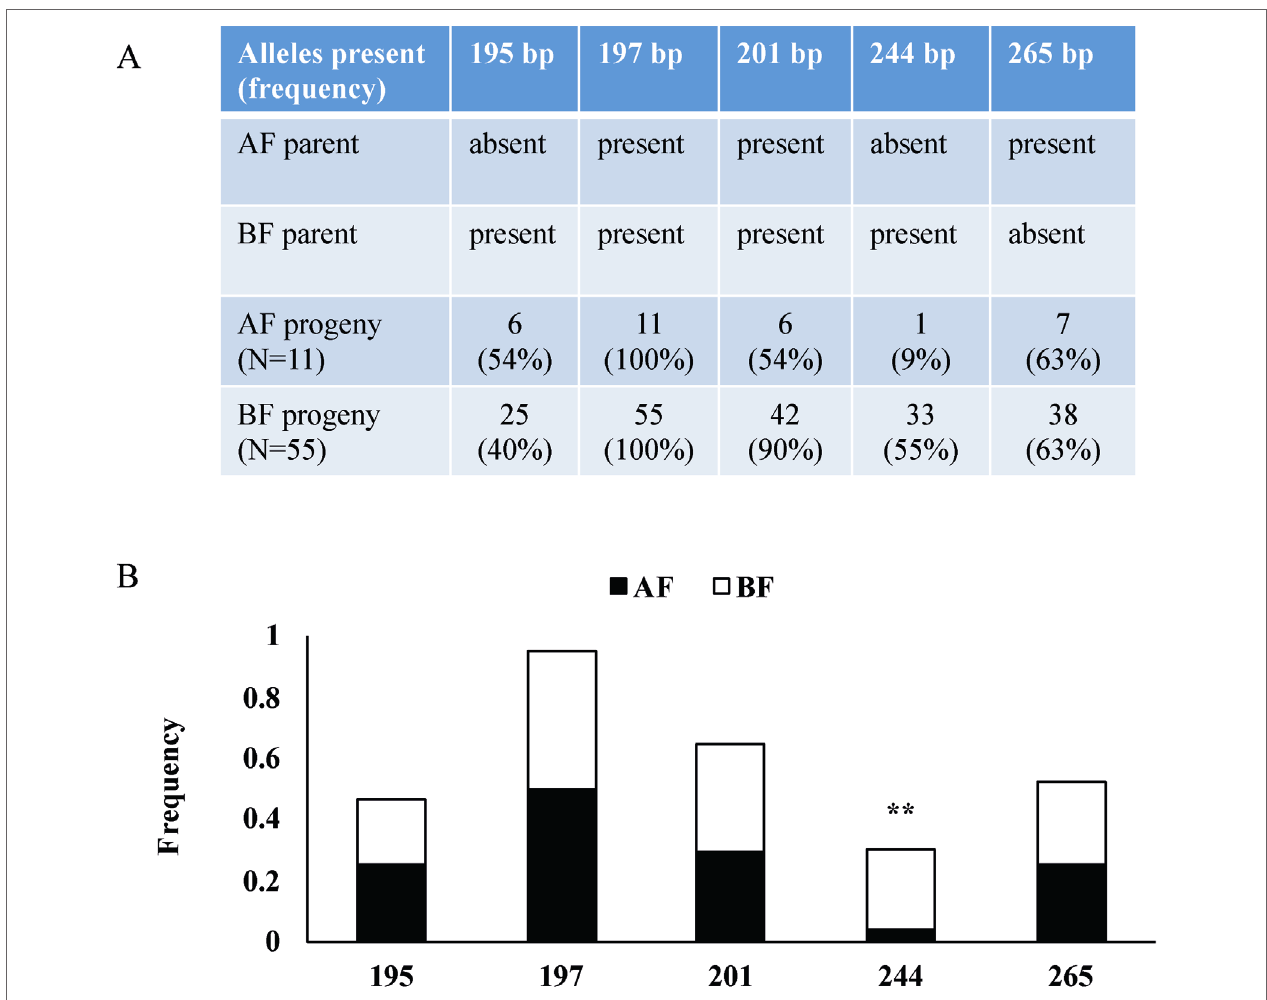
FIGURE 6 | Rubus285a marker segregation in a tetraploid blackberry mapping population segregating for Annual-Fruiting (AF). (A) Table showing the presence or absence of alleles in parents and the numbers of AF and Biennial-Fruiting (BF) progeny with each allele and the percentage in parentheses. The AF parent has three alleles with PCR product sizes of 197, 201, and 265 bp. The BF parent has four alleles with sizes of 195, 197, 201, and 244 bp. (B) Histogram showing allelic frequencies of the Rubus285a marker in the C1 blackberry population. The 244-bp allele is linked with BF trait with chi-square test significance of 99% (d.f. = 1) indicated by